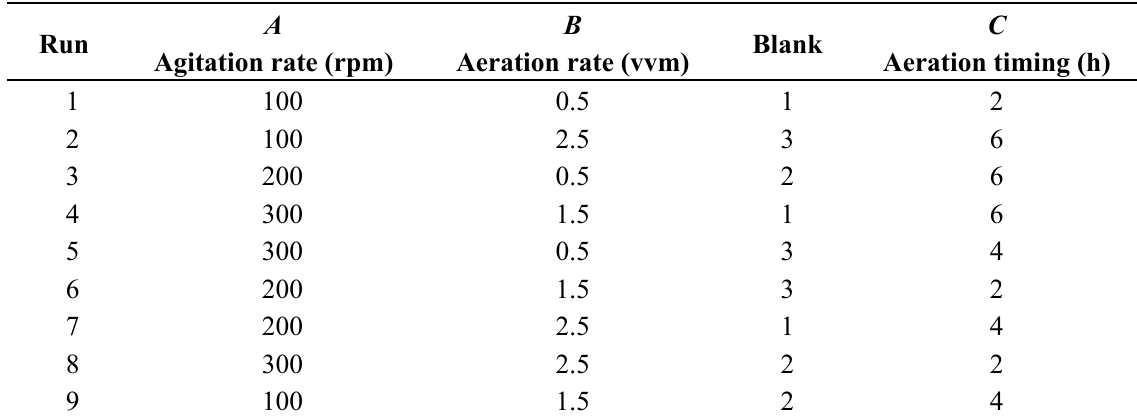
(3 4 ) orthogonal 9